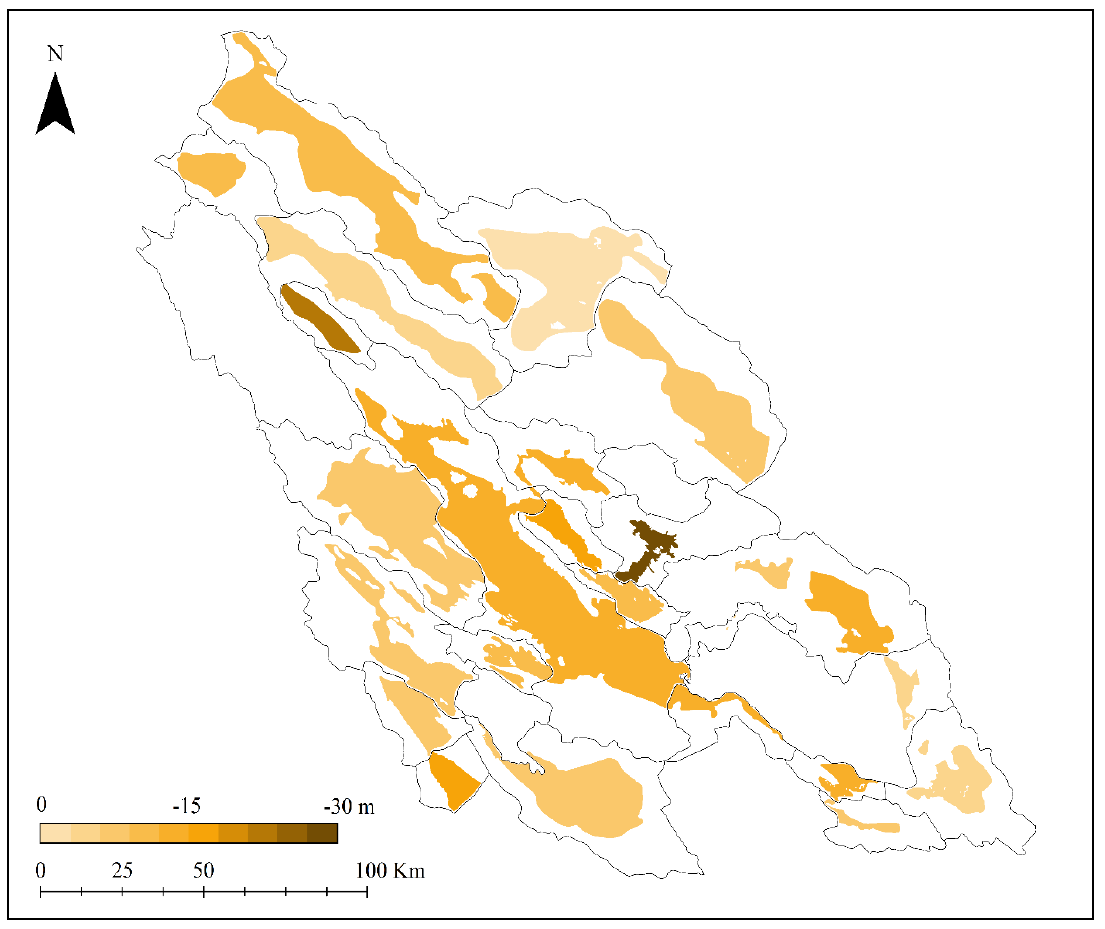
Figure 7. Total decrease (m) in groundwater level in different alluvial aquifers of the Bakhtegan catchment between January 2002 and December 2011. Contour lines show the aquifer’s boundary. The stacked bar graph shows the groundwater depletion value in the catchment during the study period.